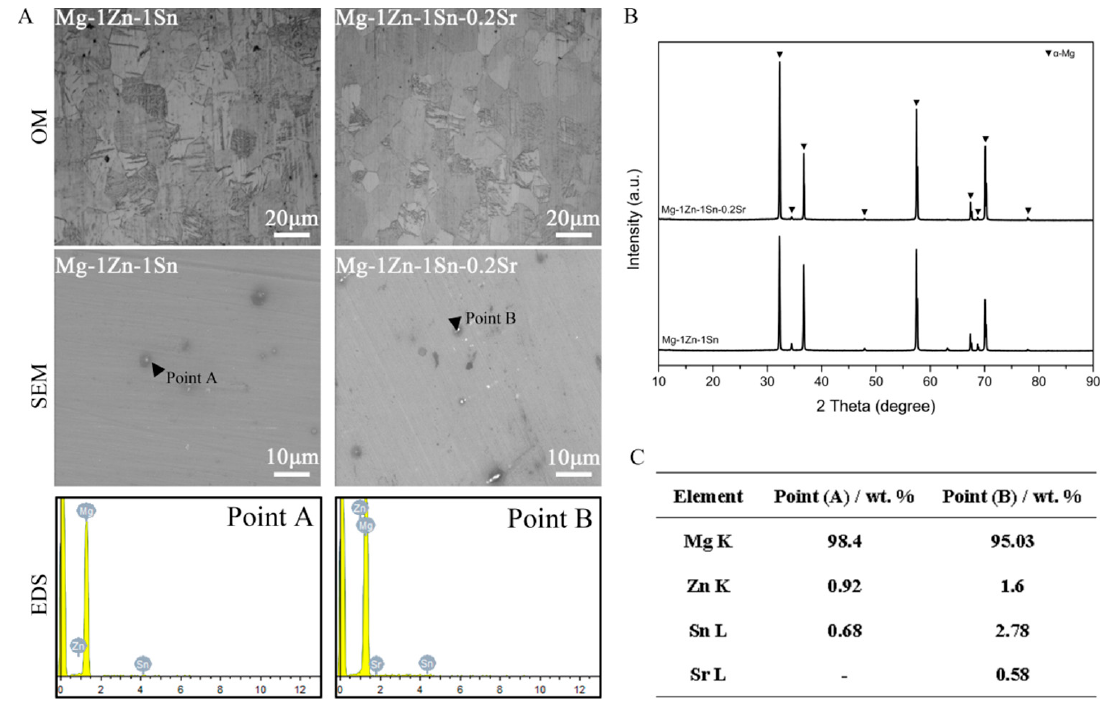
Figure 1. ( A ) Optical microstructure, SEM images, and corresponding EDS results of as-extruded Mg-1Zn-1Sn and Mg-1Zn-1Sn-0.2Sr alloys. The black triangle indicates the second phase. ( B ) XRD patterns of Mg-1Zn-1Sn and Mg-1Zn-1Sn-0.2Sr. ( C ) The chemical composition of point A and point B in Figure 1A.